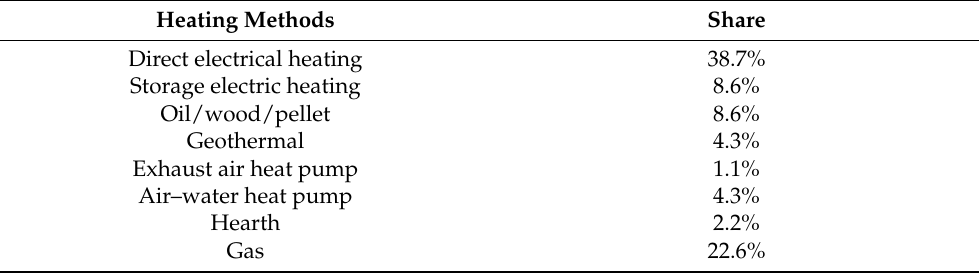
Table 7. Heating methods use in respondents house.